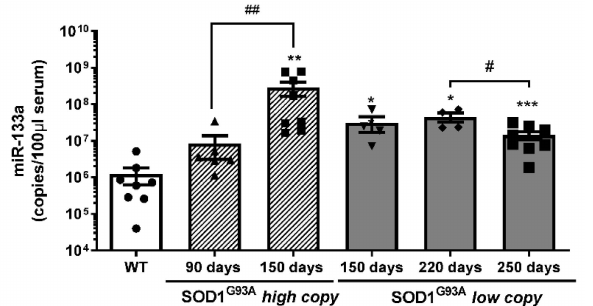
Figure 5. Serum levels of mir-133a are differently modulated during ALS disease